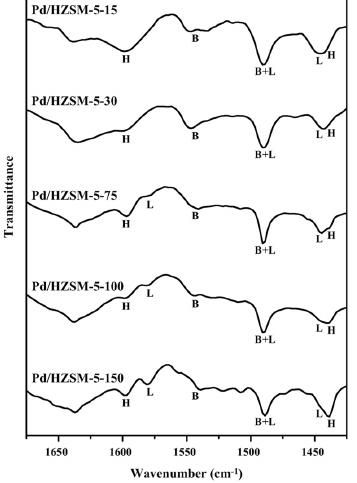
Figure 22. FT-IR spectra of pyridine adsorbed on Pd/HZSM-5-X (X = 15, 30, 75, 100, and 150) catalysts.